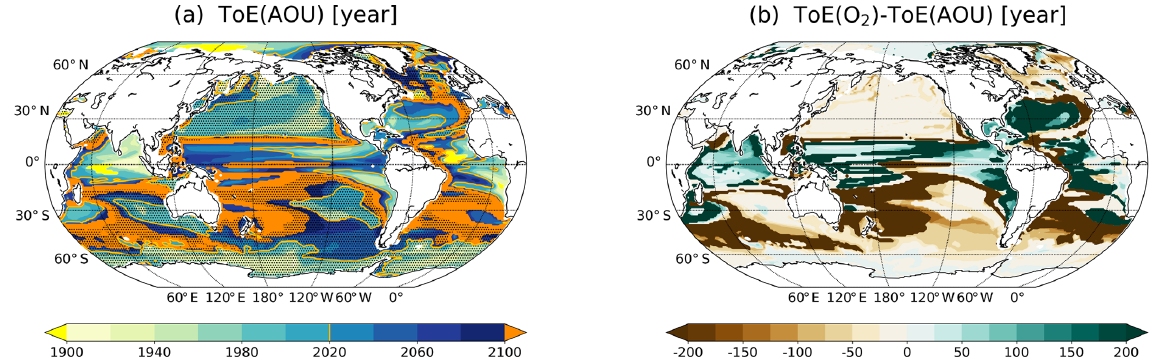
Figure 10. ToE of (a) − AOU, (b) O 2 , sol in the thermocline (200–600m). The dashed areas in panel (a) indicate where − AOU decreases under RCP8.5. Regions where the anthropogenic signal has not emerged by the end of the 21st century are indicated in orange for AOU. (b) Difference of the ToE for O 2 and the ToE of − AOU in the thermocline (200–600m).